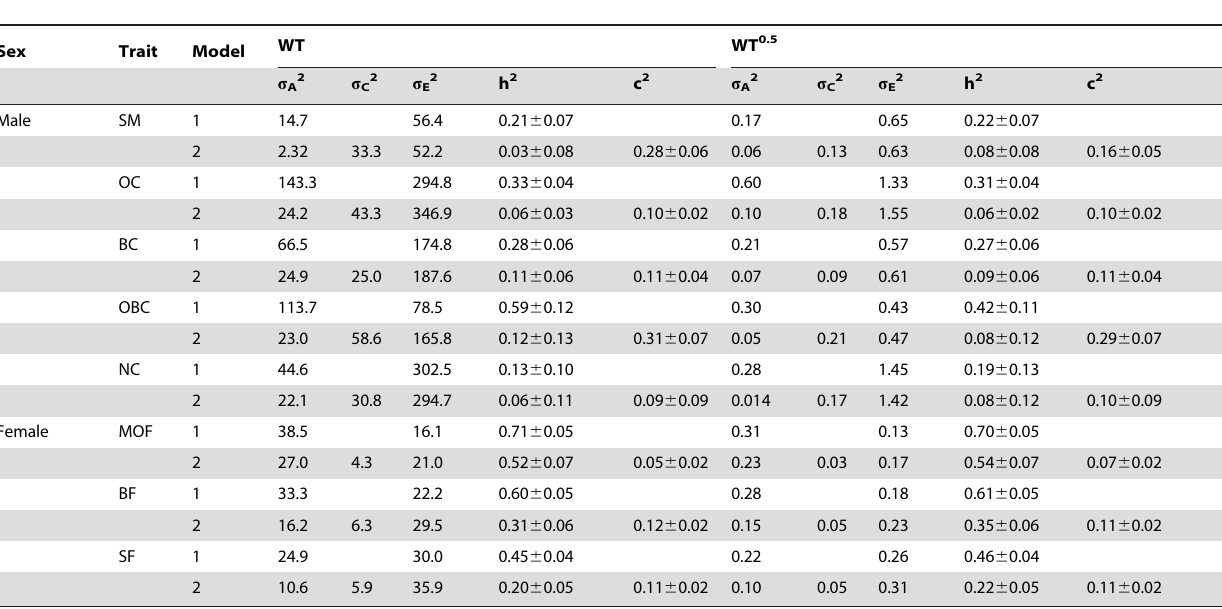
Table 5. Heritability (h 2 6 s.e.) and maternal and common full-sib effects (c 2 ) for body weight of male morphotypes and female reproductive